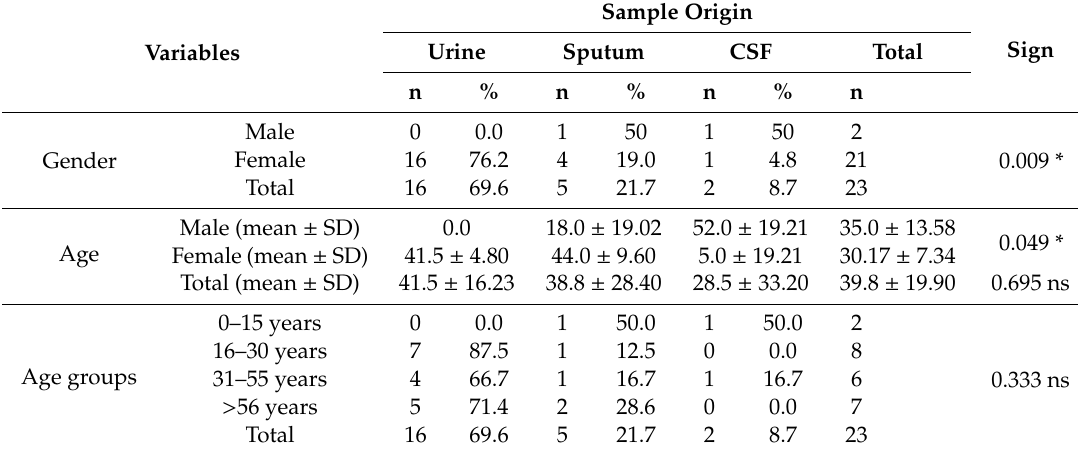
Table 2. Distribution of A. baumannii isolates according to sample